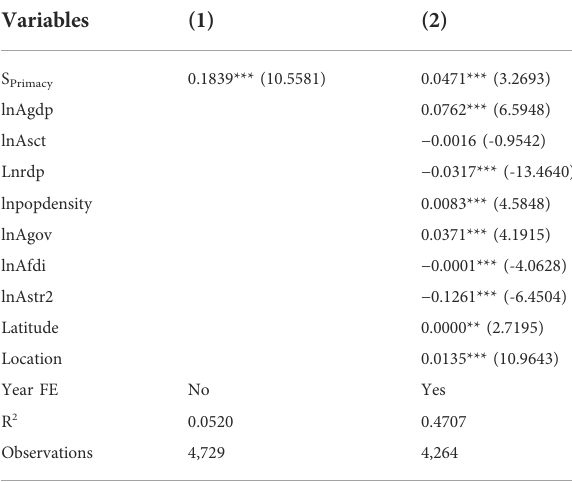
TABLE 6 Regression of urban spatial structure on environmental ef fi